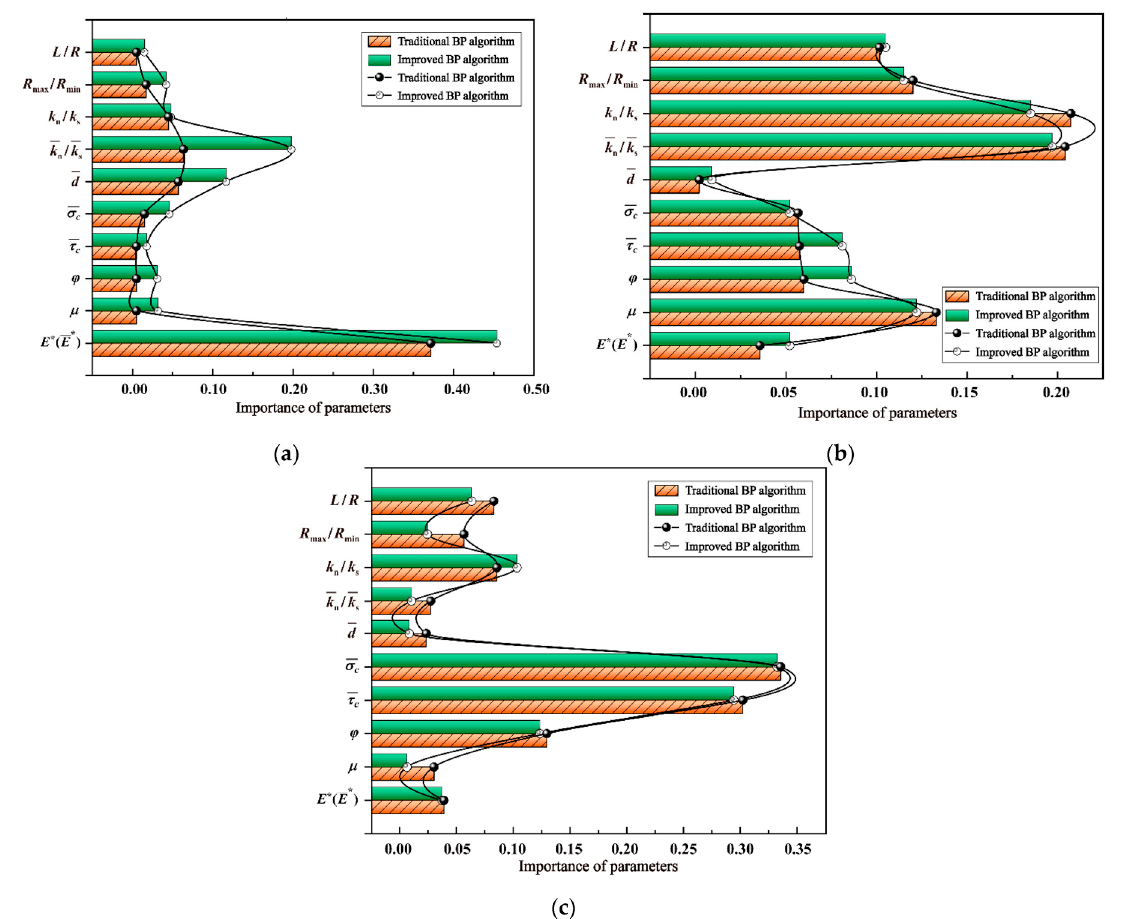
Figure 6. Results of lightweight analysis: ( a ) Between elastic modulus and meso parameters; ( b ) Be- tween Poisson’s ratio and meso parameters; ( c ) Between peak strength and meso